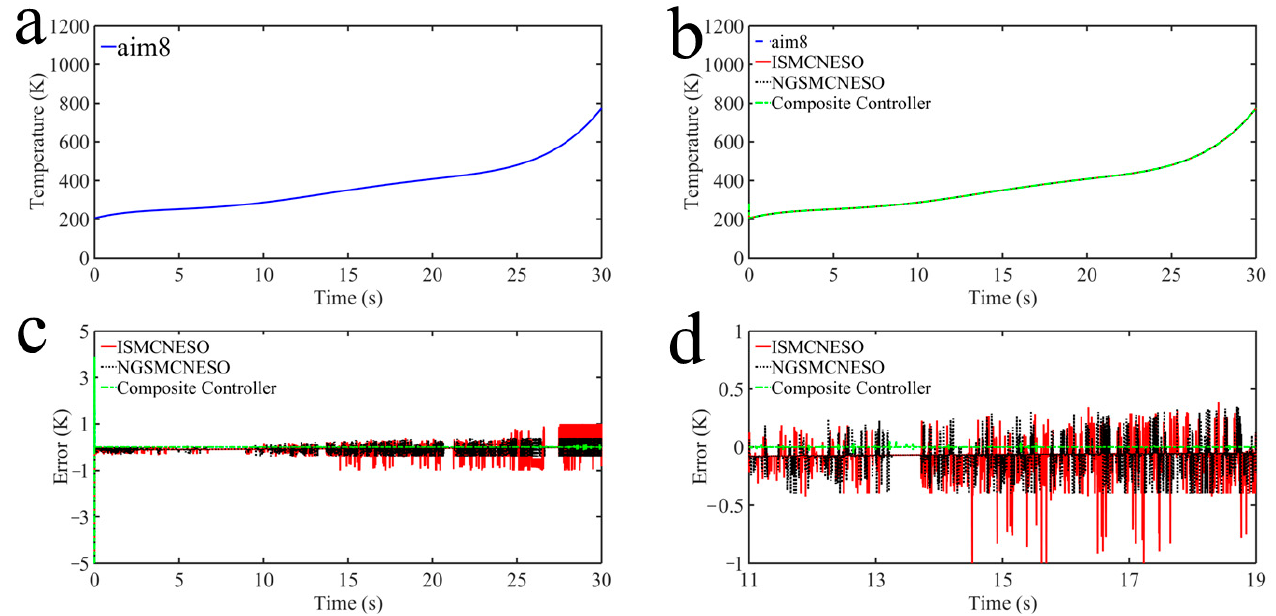
Figure 21. Simulation results: ( a ) the fitting curve of the reference temperature trajectory from Wall 2_45 mm; ( b ) the reference temperature tracking performance among ISMCNESO controller, NGSMCNESO controller, composite controller; ( c ) the tracking errors; ( d ) their partial enlarged figures in details.